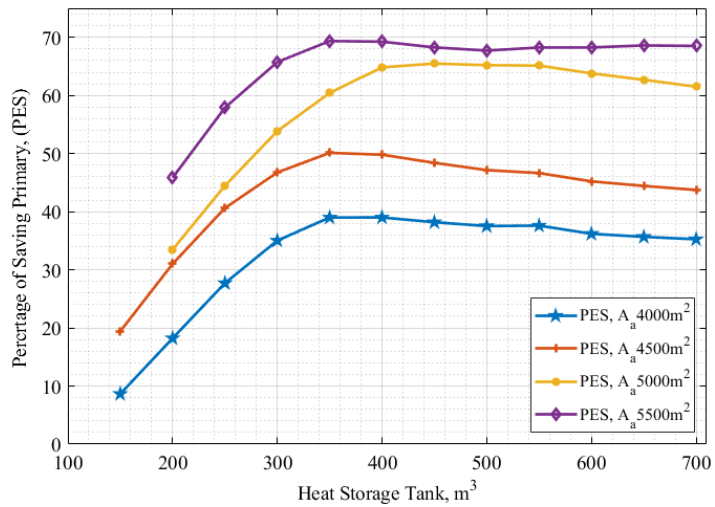
Figure 16. The primary energy saving of ADC unit vs VCC based on the storage tank volume and solar field area variations for an auxiliary set point temperature of 70 ◦ C.